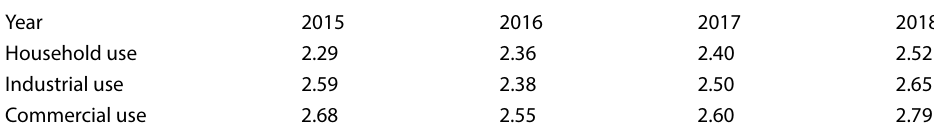
Table 6 The natural gas price in 2015–2018 (unit: CNY/m 3 )